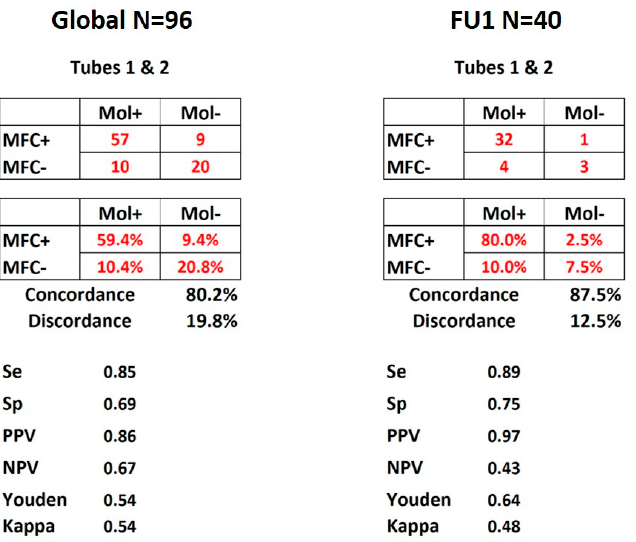
Figure 2. MRD concordance matrices. Display of the results for all 96 FU time points and FU1 of the 40 patients. Both panels show the matrices of numbers and percentages of concordance between molecular and MFC MRD detection according to the combination of tubes 1 and 2. Se: sensitivity, Sp: specificity, PPV: positive predictive value, NPV: negative predictive value. Youden and kappa tests were used and values displayed as well.